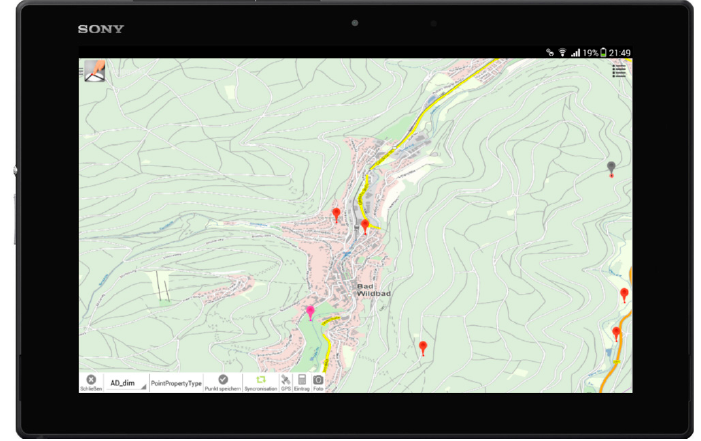
Figure 6. The mobile GIS GeoTechMobile.